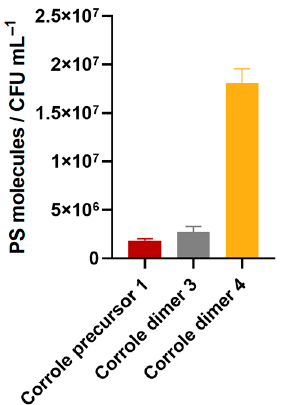
Figure 4. Quantification of adhesion of PS molecules to S. aureus bacterial cells after 15 min of dark incubation at room temperature at a concentration of 15 µM for each PS tested. The data values represent the mean of three independent experiments. Error bars represent the standard deviation between the experiments.